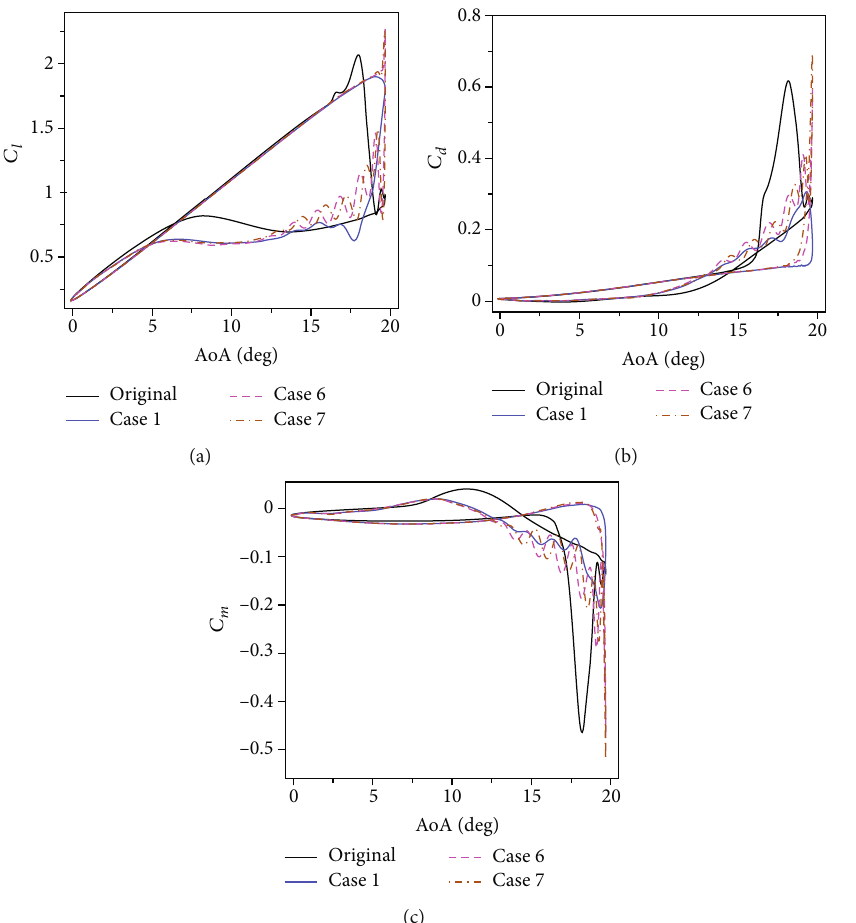
Figure 28: Comparison of aerodynamic coe ffi cients for Cases 1, 6, and 7: (a) lift coe ffi cients, (b) drag coe ffi cients, and (c) pitching moment coe ffi